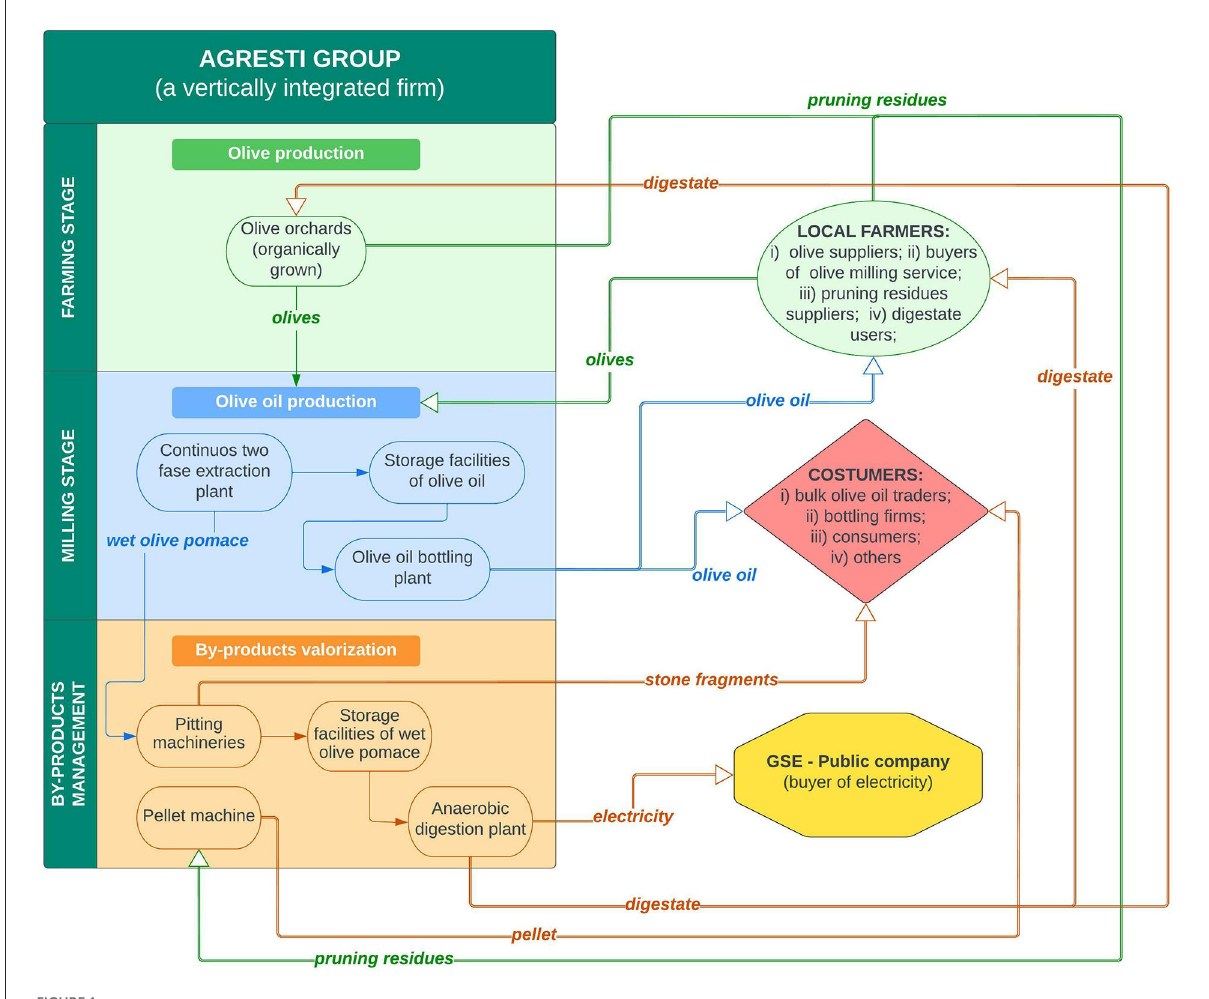
FIGURE1 Main activities and product flows related to the Agresti group.